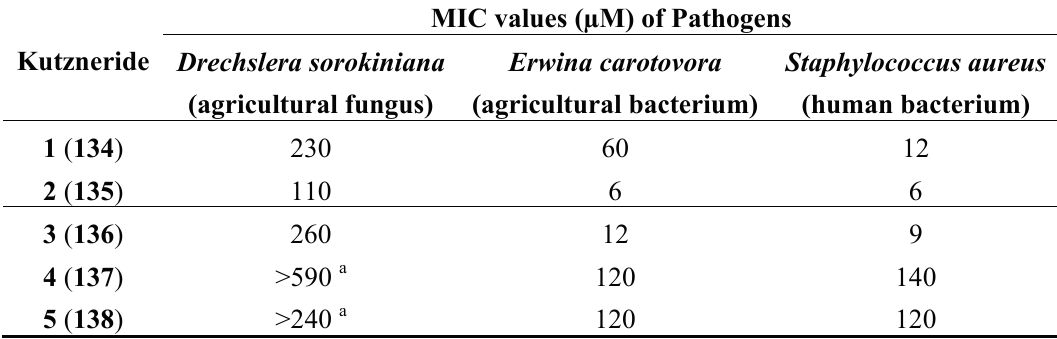
Table 4. MIC values of kutznerides against various